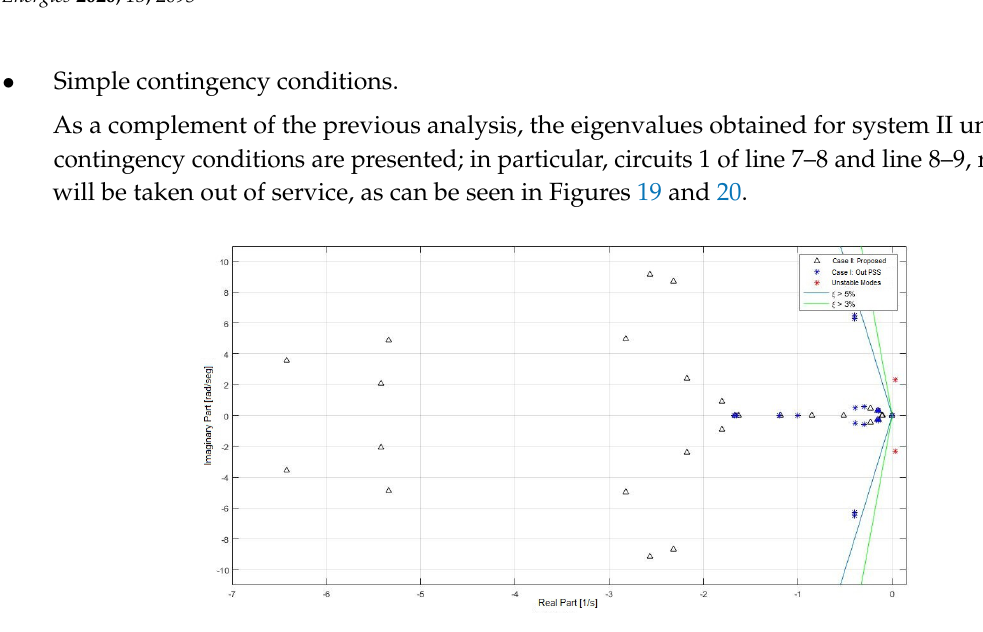
Figure 19. Eigenvalues system II-C1 Line 7–8 out service.